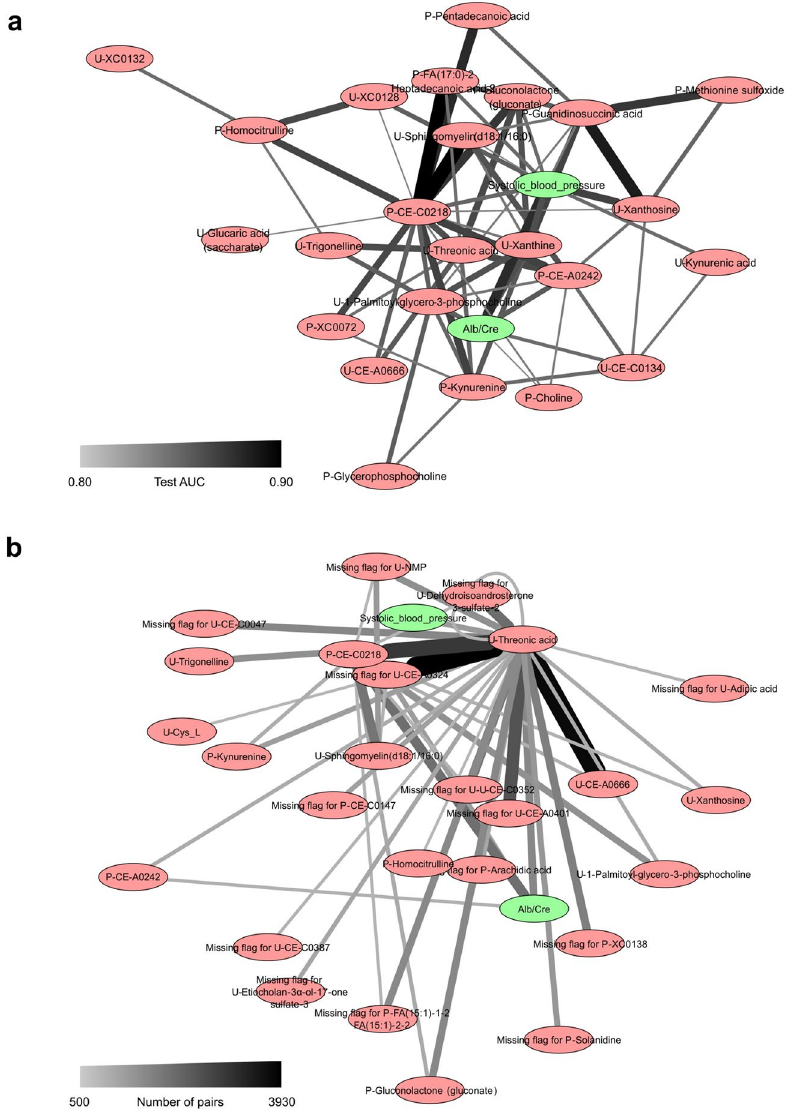
Figure 4. Graph network of features in PWL models and HCLR models. Graph network derived from high- AUC models of ( a ) PWL and ( b ) HCLR. The width of an edge between two nodes represents the interaction strength between the biomarker candidate’s pair that the two nodes represent. For visibility, we ignored all nodes whose interaction strength was smaller than a threshold value: 0.8 in PWL models and 500 in HCLR model. PWL piecewise linear, HCLR handcrafted linear